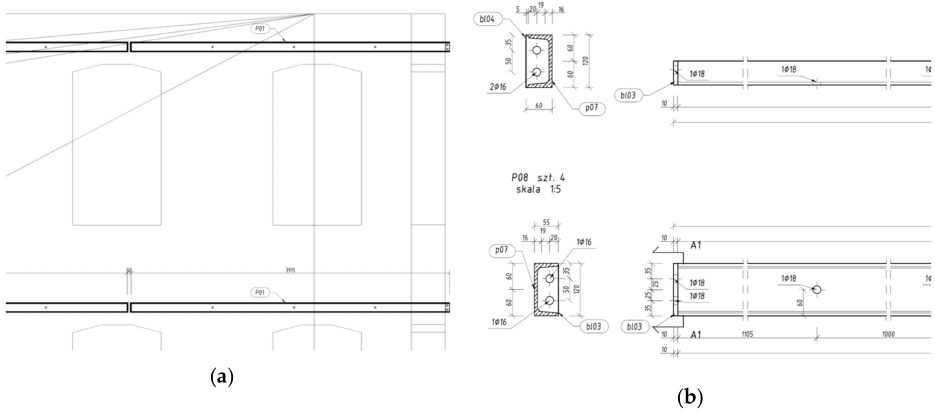
Figure 14. Proposed reinforcement solution for studied building: ( a ) front; ( b )